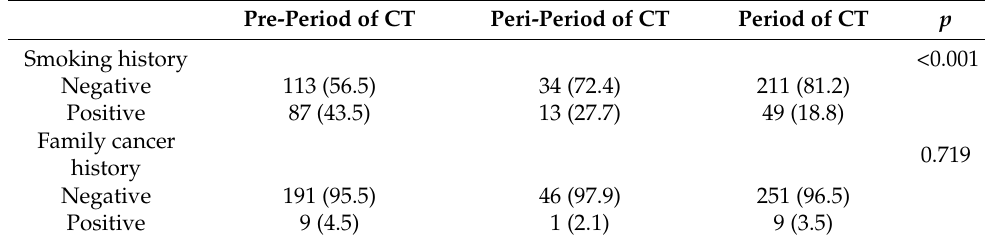
Table 3. Distribution of risk factors among lung cancer